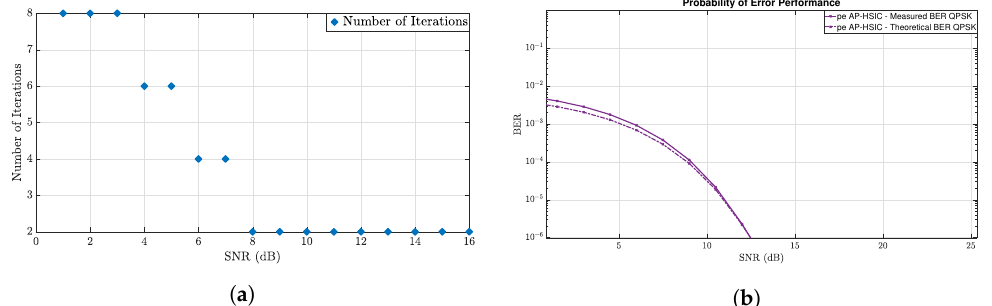
Figure 6. Number of iterations of the AP-HSIC and measured-theoretical AP-HSIC QPSK BER: ( a ) Number of iterations of the AP-HSIC vs. SNR under QPSK modulation; and ( b ) Comparisons between the measured-theoretical AP-HSIC QPSK BER.